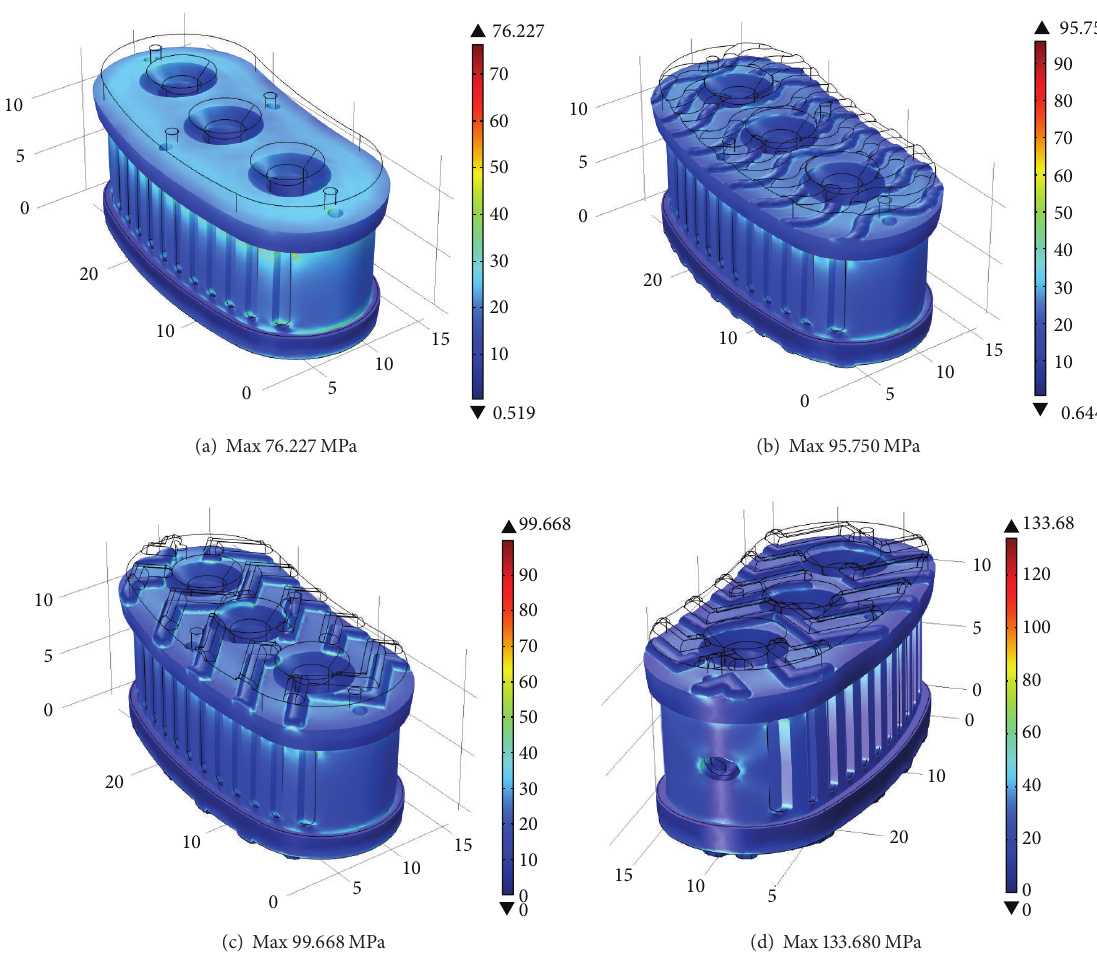
Figure 7: Volumetric analysis: von Mises stress distribution with 4,000 N as reference